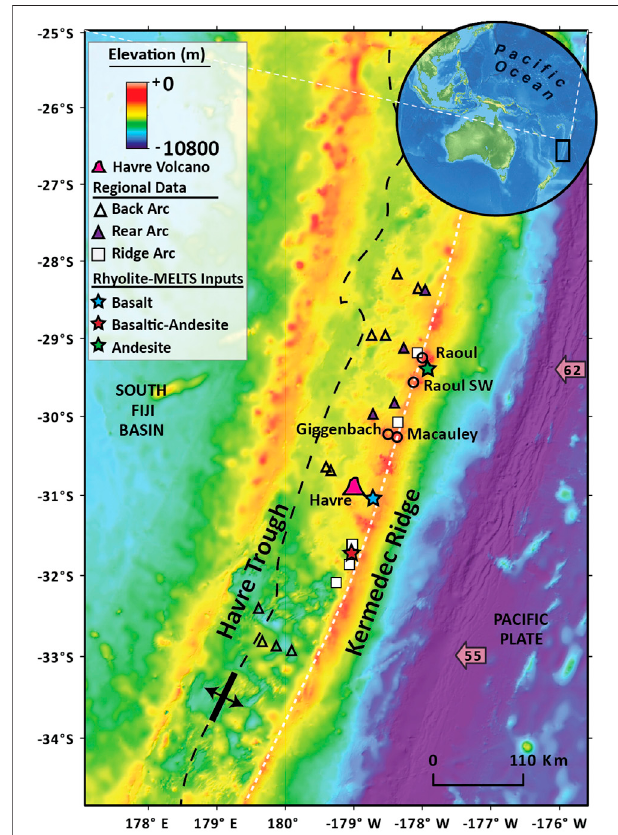
FIGURE 1 | Bathymetric map of the Kermadec subduction system. Havre volcano is denoted by a pink volcano symbol. Location of dredge samples from Hauff et al. (2021) is presented from the back-arc (open triangles), rear-arc (purple- fi lled triangles), and frontal ridge arc (white- fi lled boxes). Ridge-arc samples refer to samples dredged off the fl ank on the KermadecArcridgeinferredtoberelatedtoprimary-arcmagmatism.Reararc samples refer to samples dredged off-axis to the west of primary volcanic arc ridge. Back-arc dredge samples refer to samples dredged from regions related to back-arc extension during the formation of the Havre Trough. Dredge compositions inputted in rhyolite-MELTS models are denoted by stars. The Kermadec frontal arc ridge, where most of the active arc volcanoes are located in the region, is denoted by the white dashed line. The Havre Trough back-arc basin spreading center is outlined by the back dashed line with arrows denoting the spreading direction. Bathymetric data are sourced from GEBCO-15 arc seconds of resolution (Tozer et al.,